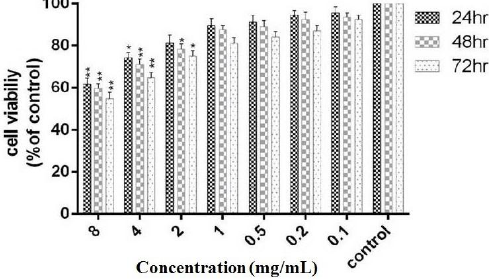
Fig. 4. Comparison the cytotoxicity effect of different concentrations of the extract on MRC5 cell line after 24h,48h,72h (n=4, p<0.01**, p<0.01**, p<0.05*).